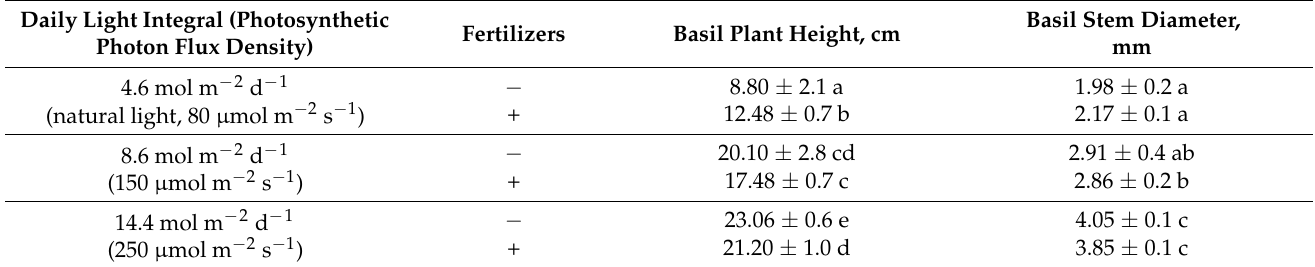
Table 2. The effect of light intensity and fertilizer on basil high and stem diameter. Values are mean ± SE of 5 replicates, and values with different letters in columns differed significantly according to Tukey multiple comparison test ( p ≤ 0.05).